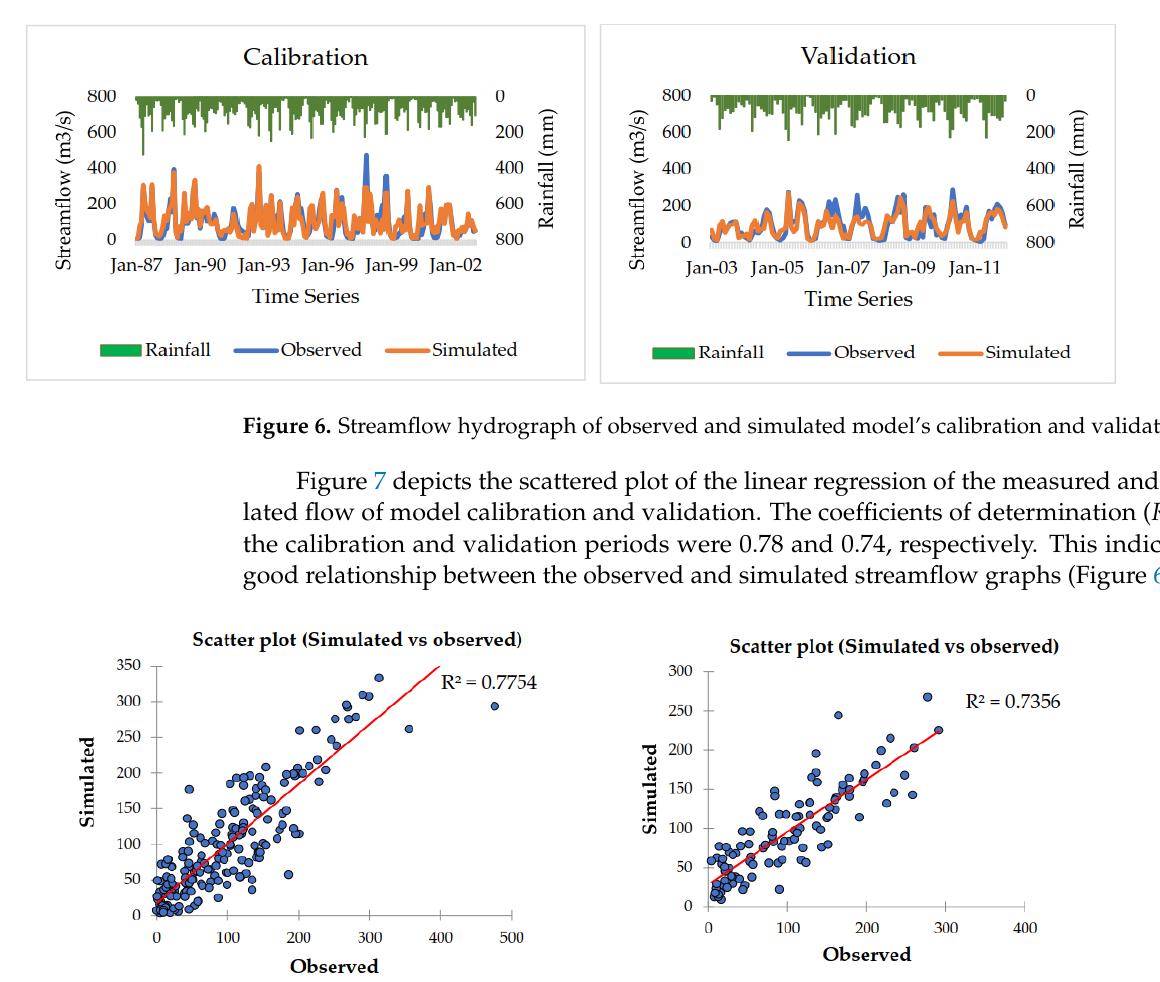
Figure 7. Scatter plot of measured and simulated streamflow; left panel shows the calibration period and right panel shows validation period.